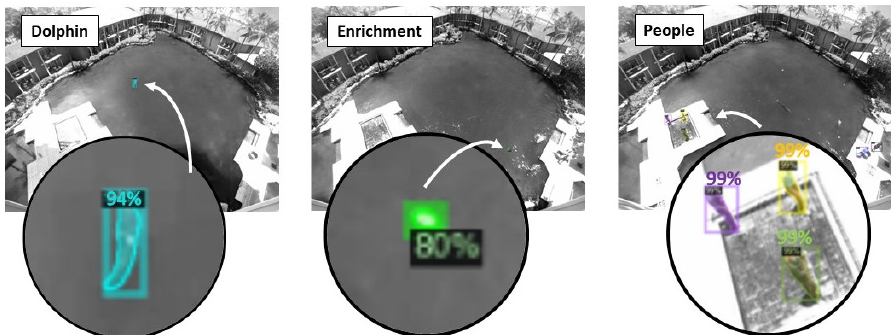
Figure 1. Example detections of a dolphin, floating enrichment (a buoy), and people in the la- goon environment. Each detected object is shown with its corresponding mask and the likelihood of